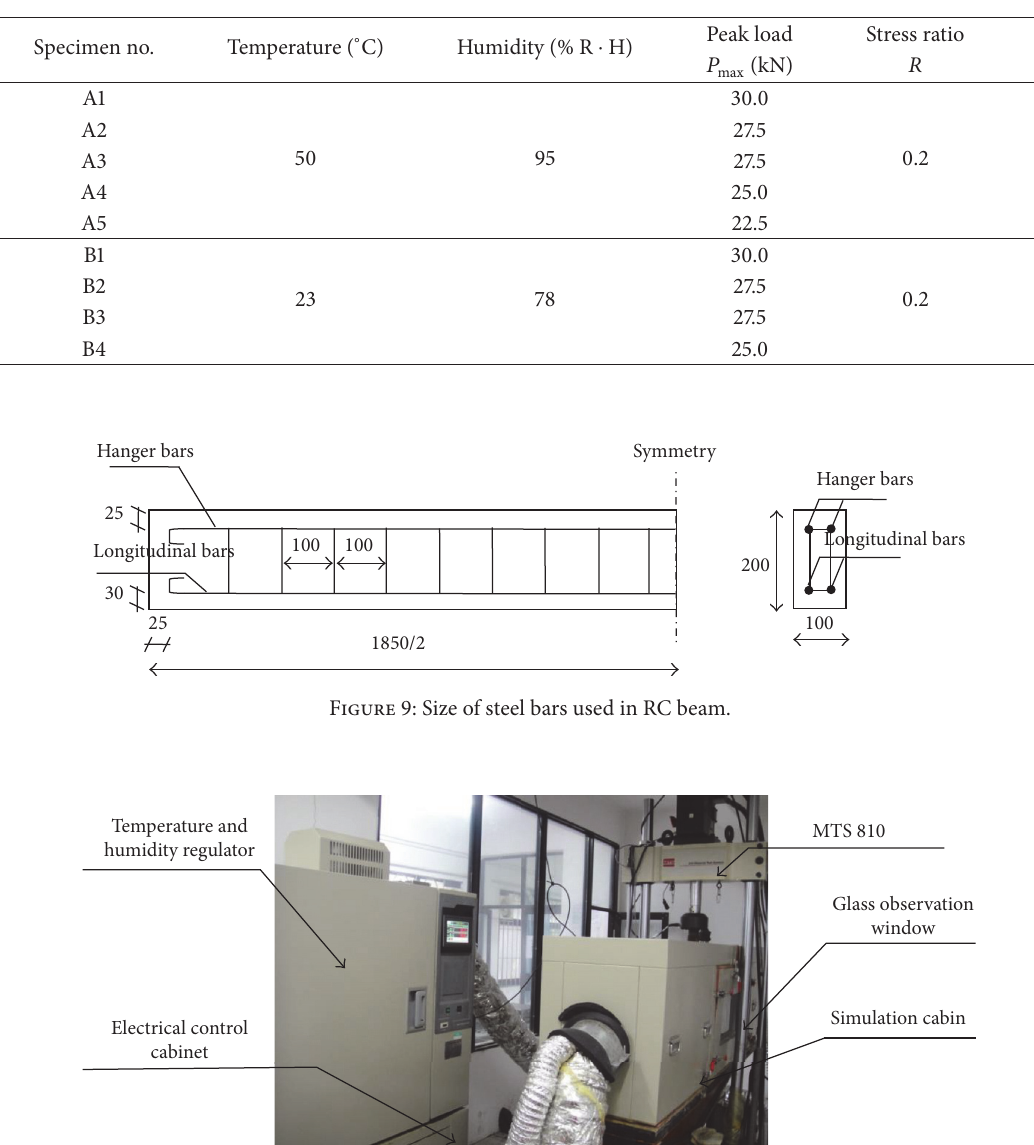
Table 2: Fatigue crack propagation test conditions and results.